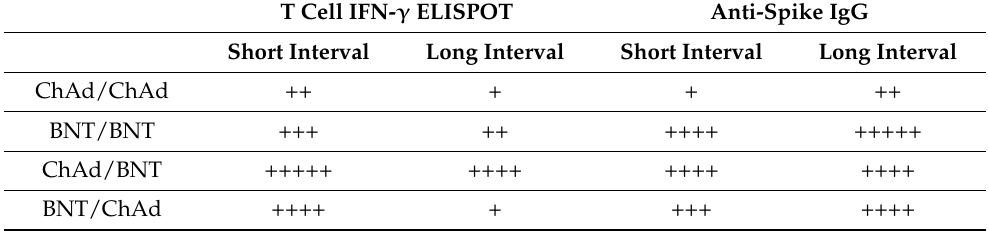
Table 1. T cell and antibody response following anti-SARS-CoV-2 vaccination performed with four different vaccine combinations and two time-lengths of prime/boost interval. This table is based on a publication selected because at this time, to our knowledge, it is unique in making the comparison of four vaccine combinations and two time intervals in a randomized study [105]. To assess the effects of short versus long prime/boost interval on vaccinations performed with different vaccine combinations, adult volunteers were randomly divided into eight groups. Each group was vaccinated with one of four different prime/boost vaccine combinations (ChAd/ChAd, BNT/BNT, ChAd/BNT and BNT/ChAd), each performed according to either a 4-week or a 12-week prime/boost interval. Serum antibody titres were measured, and T cell responses assayed by IFN- γ ELISPOT at different times after boosting, up to 7 months. The table is based on quantitative data at 1-month post-boost. A slow decline was observed at later time points, nevertheless, differences between the short and long interval for each vaccine combination were maintained overall. For more details see original publication